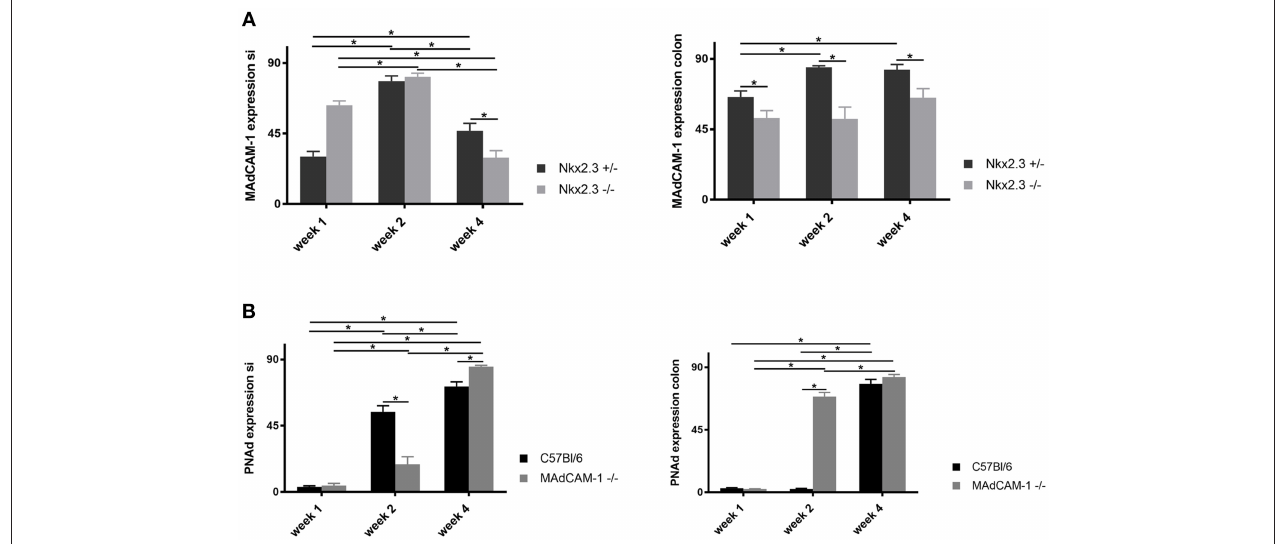
FIGURE 4 | Quantification of the expression of endothelial addressins in the postnatal period. (A) Relative pixel intensities (mean gray values, y -axis) of MAdCAM-1 labeling of small intestine (left) and colon (right) in Nkx2-3 + / − (black filled) and Nkx2-3 − / − (gray filled) at the periods indicated at the x -axis ( n = 5, mean ± SEM, in a